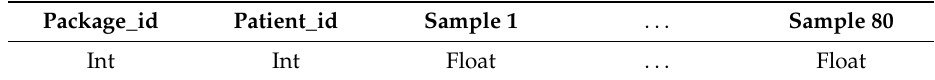
Table 4. Electrocardiogram